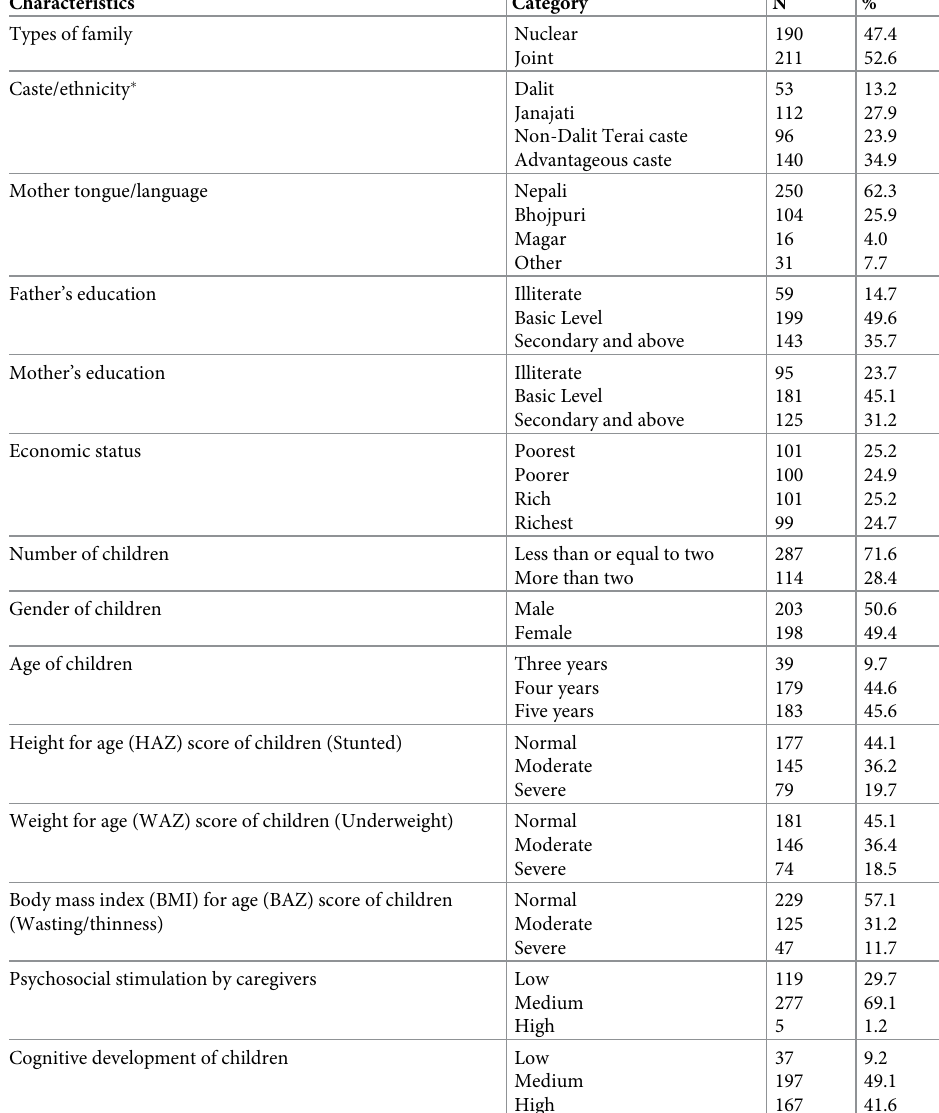
Table 1. Distribution of sample characteristics (n =